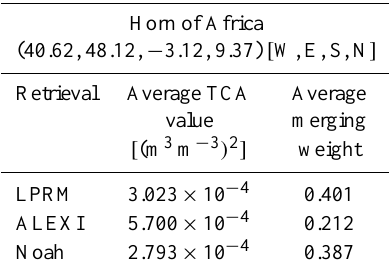
Table 3. Average merging weight and TC error values for the Horn of